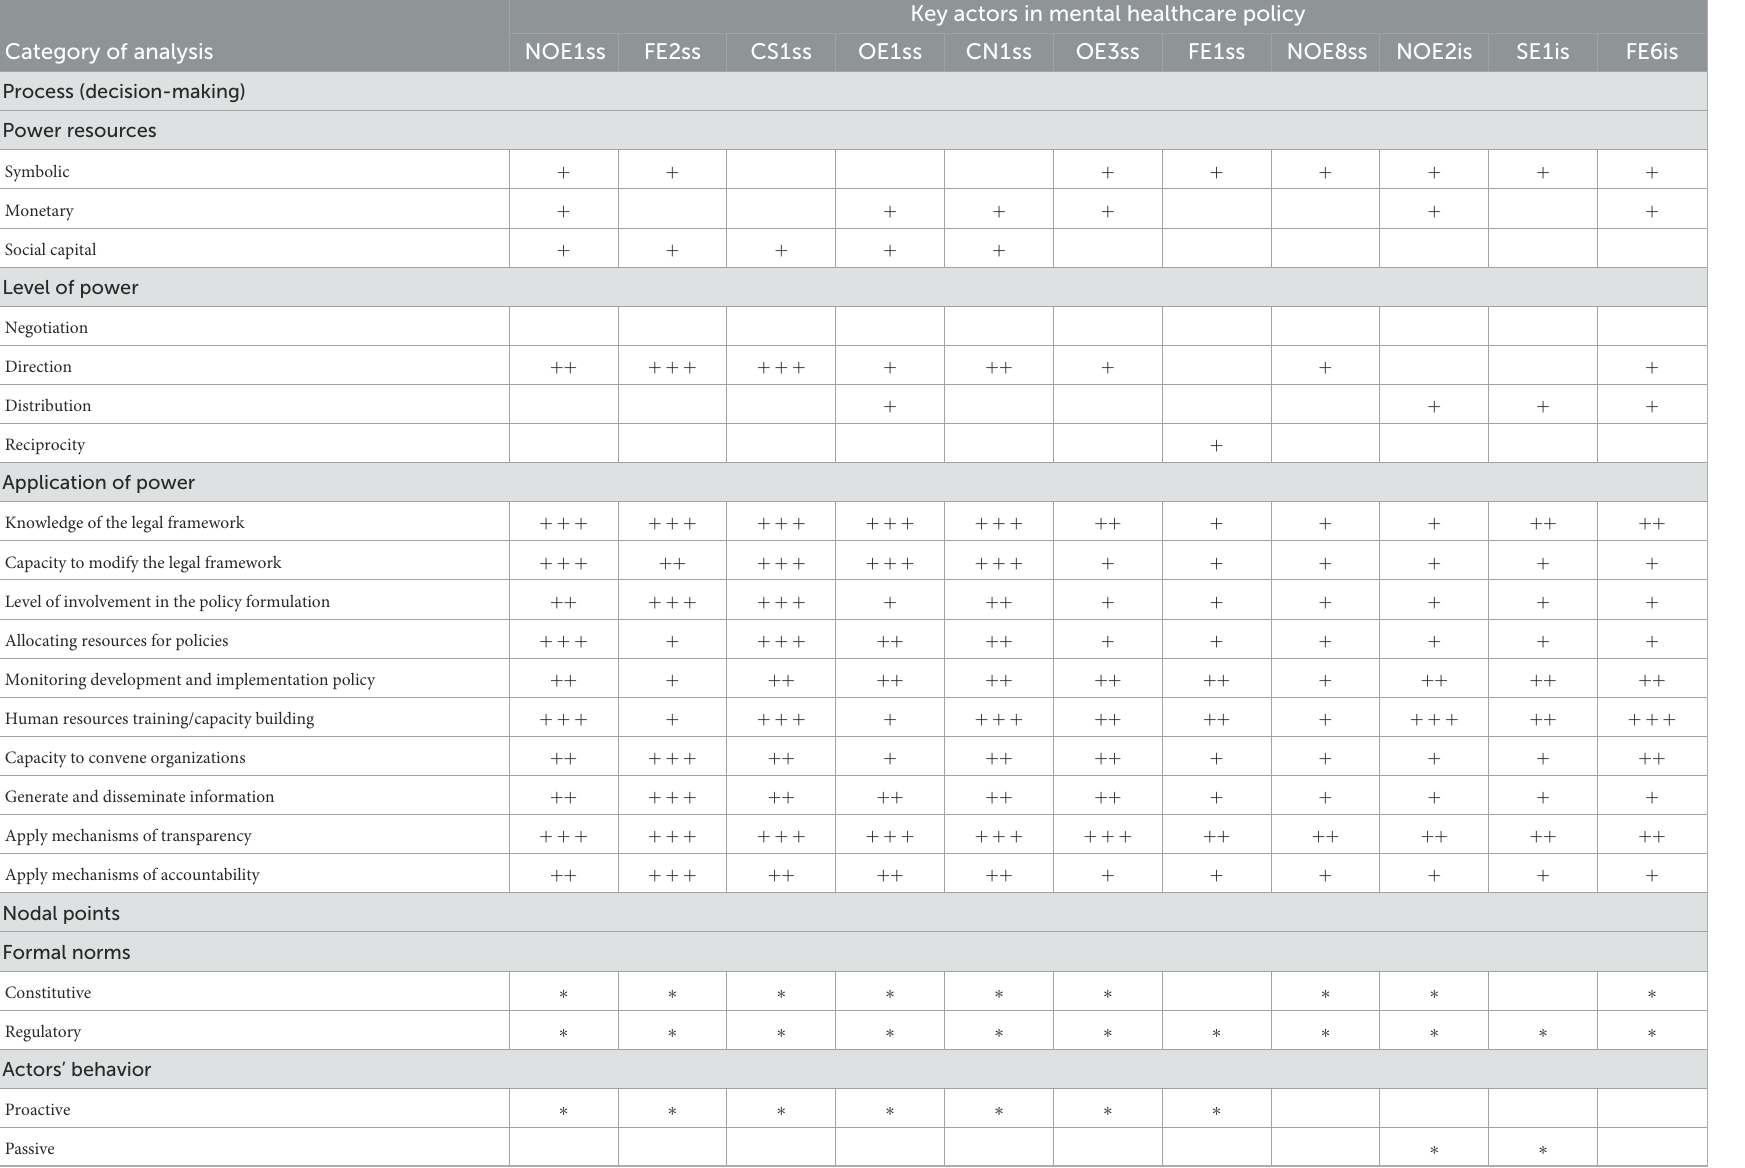
TABLE 3 Social norms and scope of decision-making by key actors in Mexico’s health system. Category of